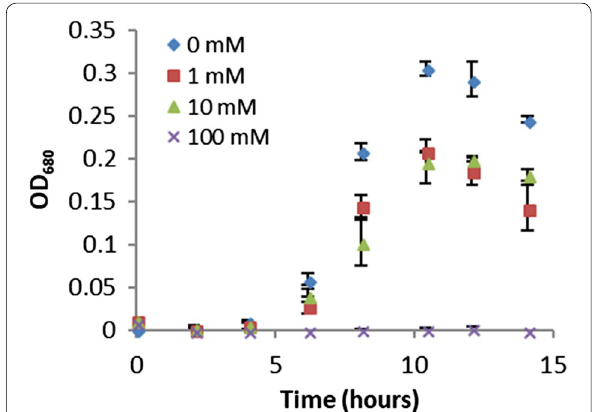
Fig. 1 Caldicellulosiruptor bescii strain JWCB018 grown in increasing concentrations of sodium benzoate. Growth inhibition is observed at concentrations of 1 mM sodium benzoate and above. Error bars represent the standard deviation from analysis of 3 replicate cultures